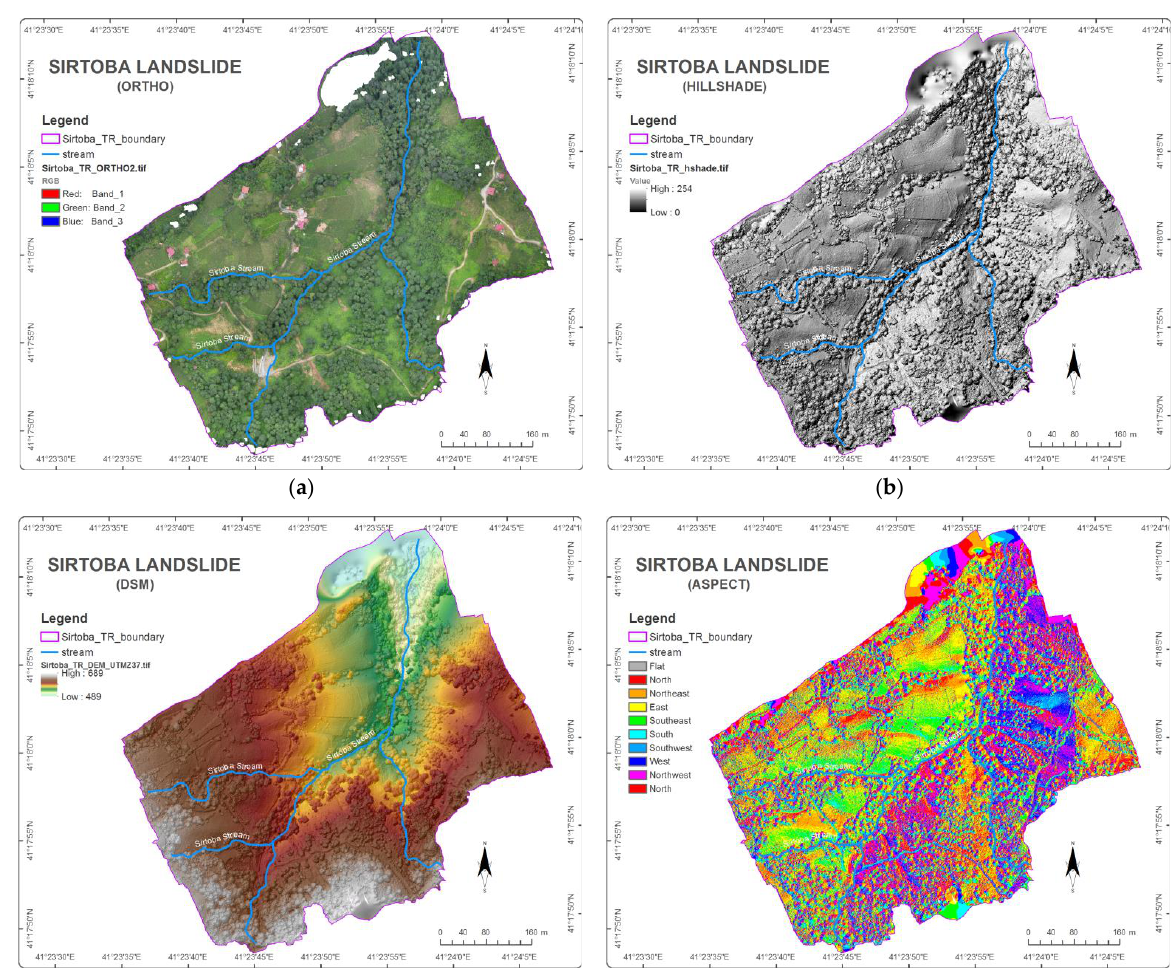
Figure 7. The case study of Sirtoba in Turkey captured by the drone flight on 13 August 2022: ( a ) orthomosaic; ( b ) hillshade; ( c ) DSM; and ( d ) aspect. ( a ) orthomosaic; ( b ) hillshade; ( c ) DSM; and ( d )